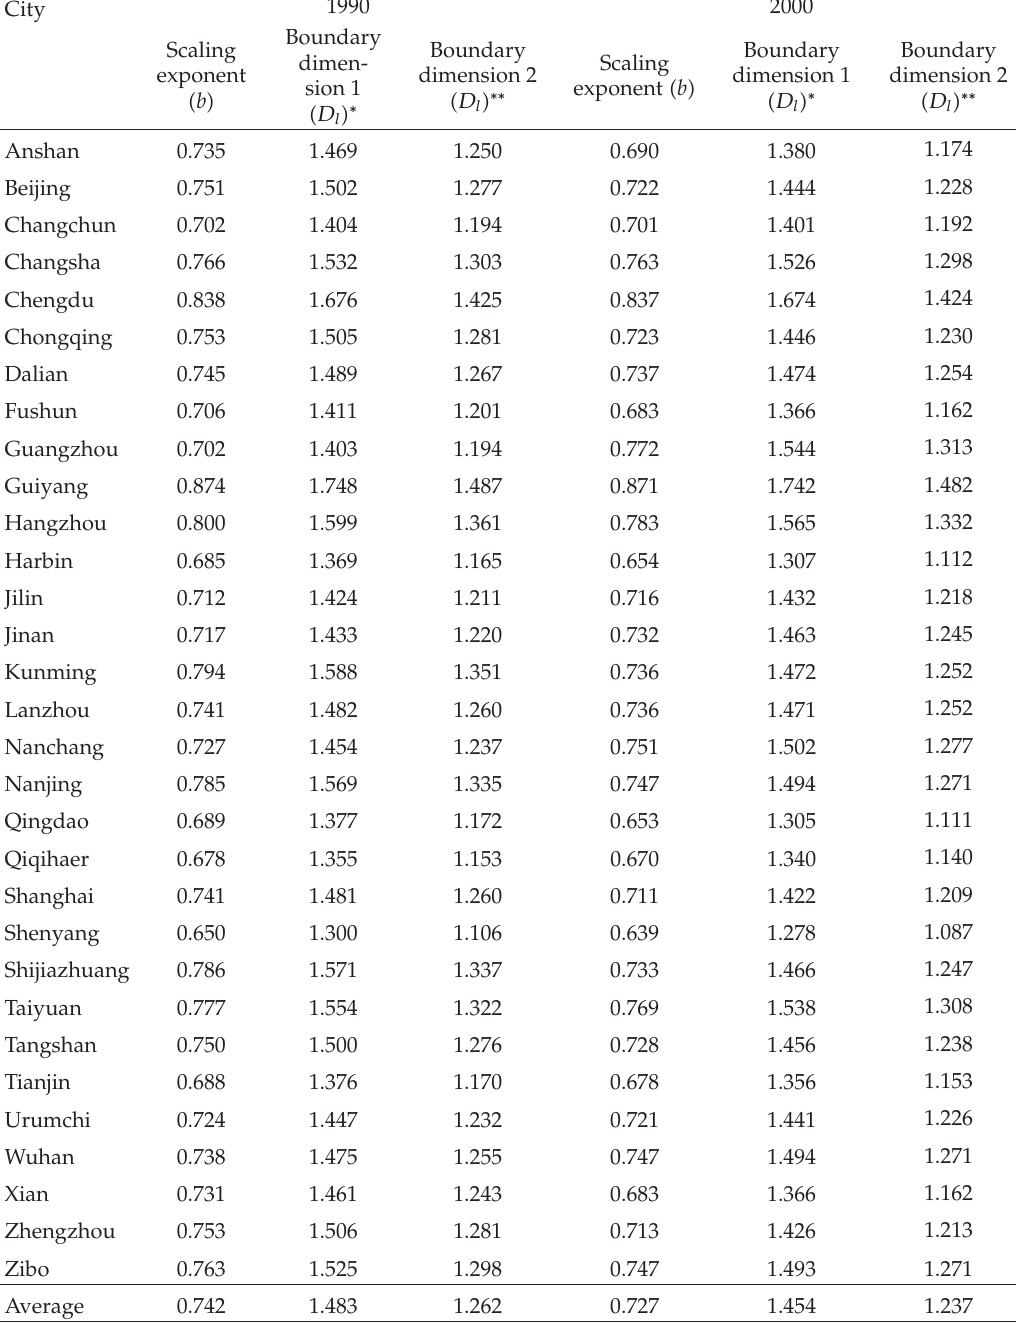
Table 1: The fractal dimension values of urban boundaries and ASEs of the area-perimeter relations of 31 megacities in China in 1990 and